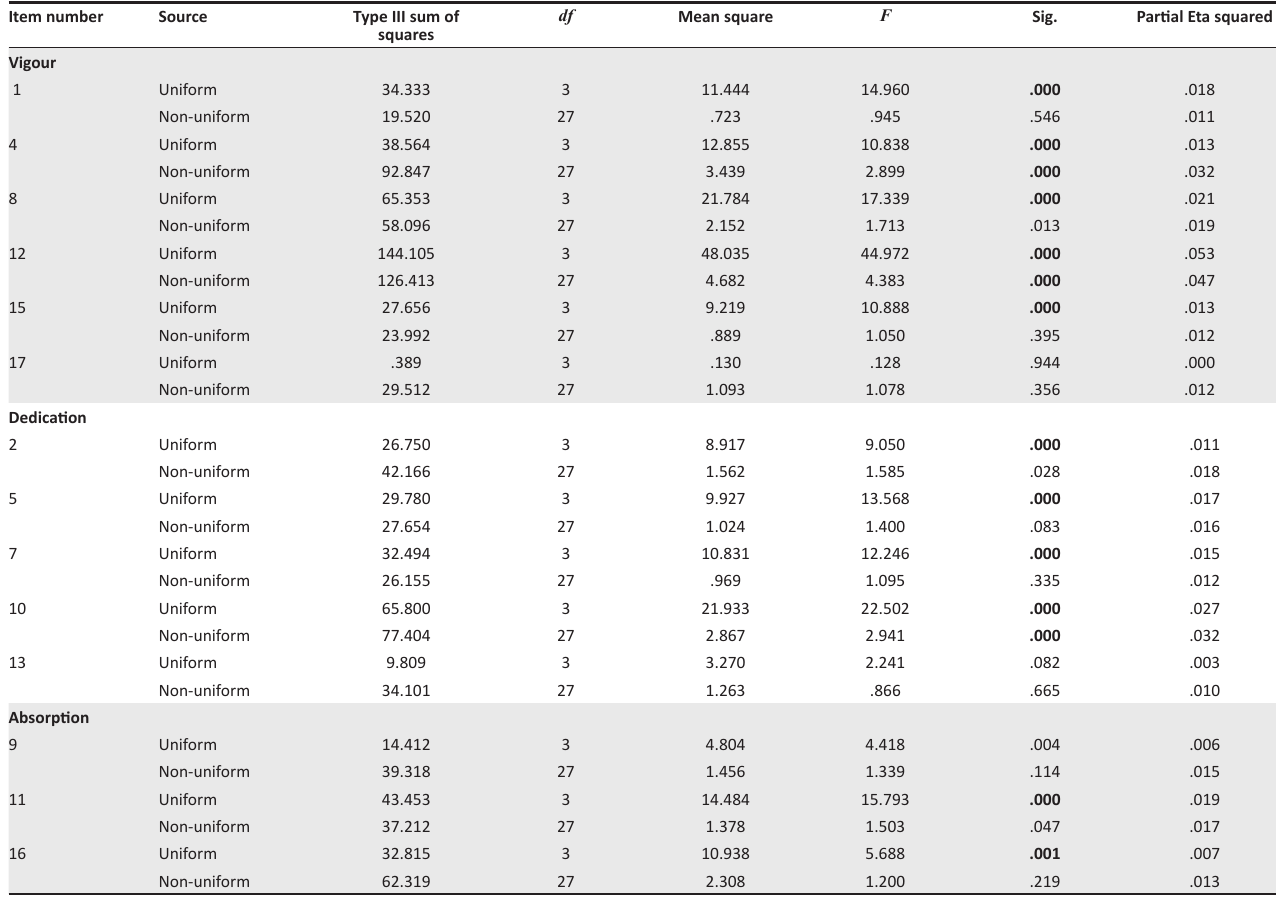
TABLE 7: Summary of uniform and non-uniform bias for items on the vigour, dedication and absorption sub scales.